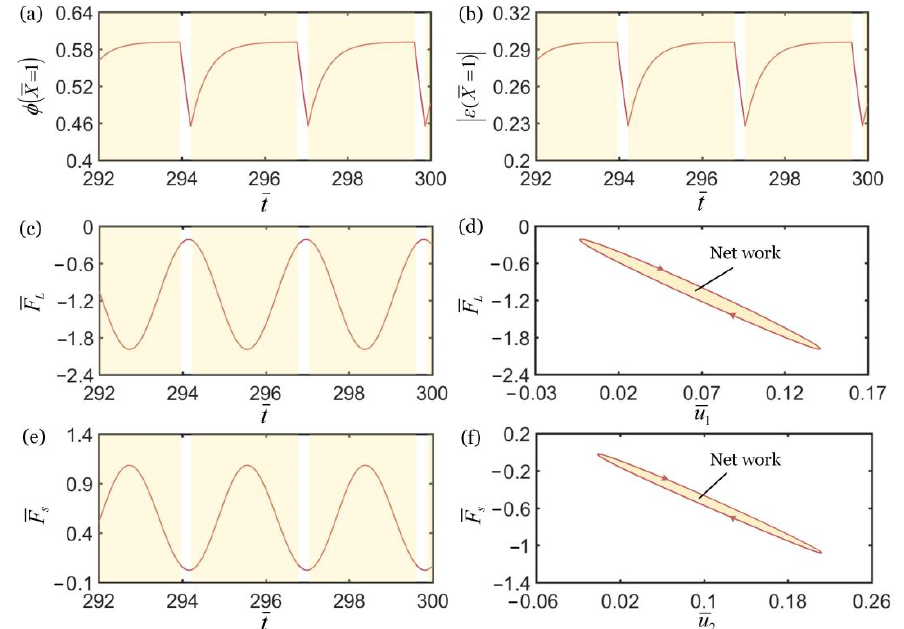
(cid:0) (cid:1) = k X = 1 16 in Figure 2. ( a ) 2 vs.